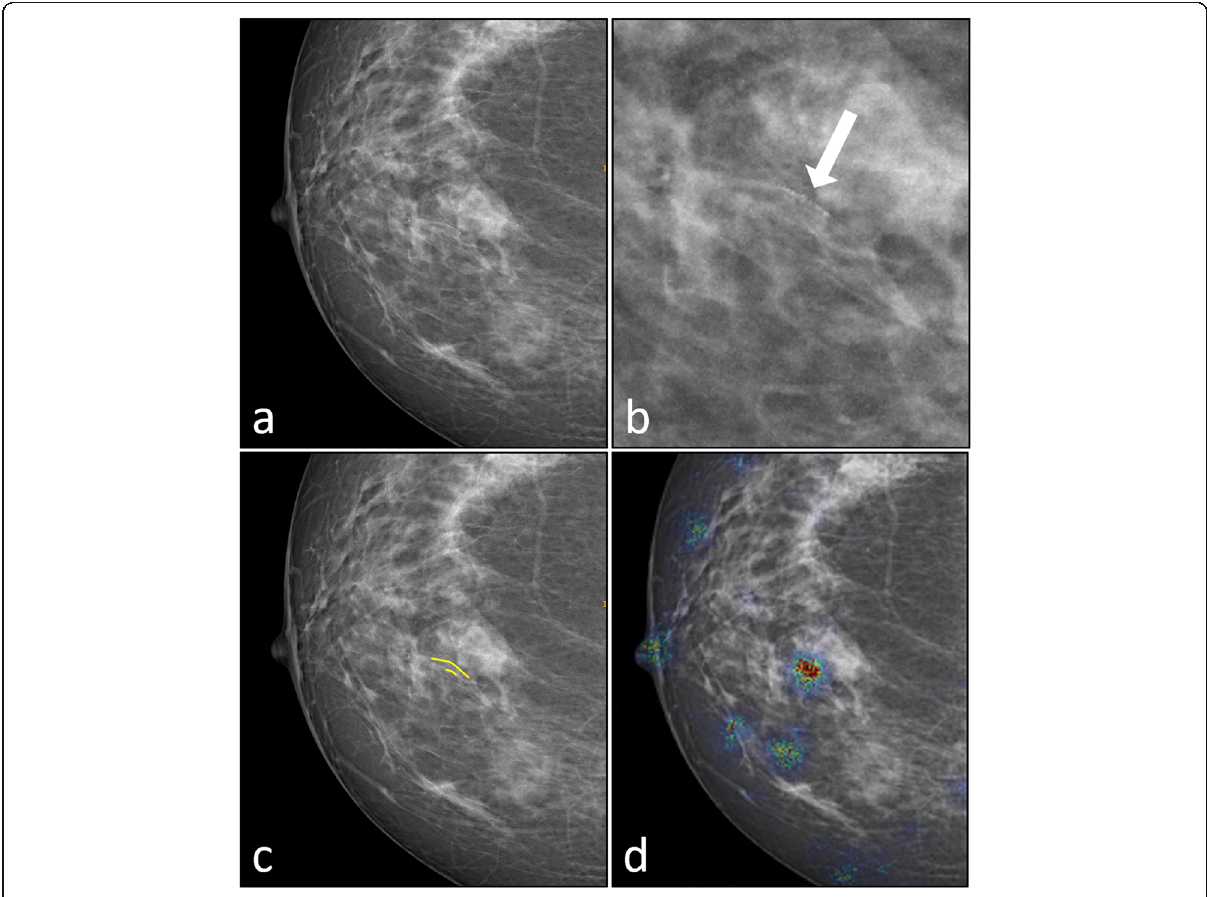
Fig. 1 Breast arterial calcifications (BAC) detection by convolutional neural network (CNN). a Original image (positive to BAC presence). b Detail including the unsegmented BAC (white arrow). c Heat map provided by the CNN. d Annotated image (BAC in yellow). The heat map ( c ) has the reduced resolution of images input to the